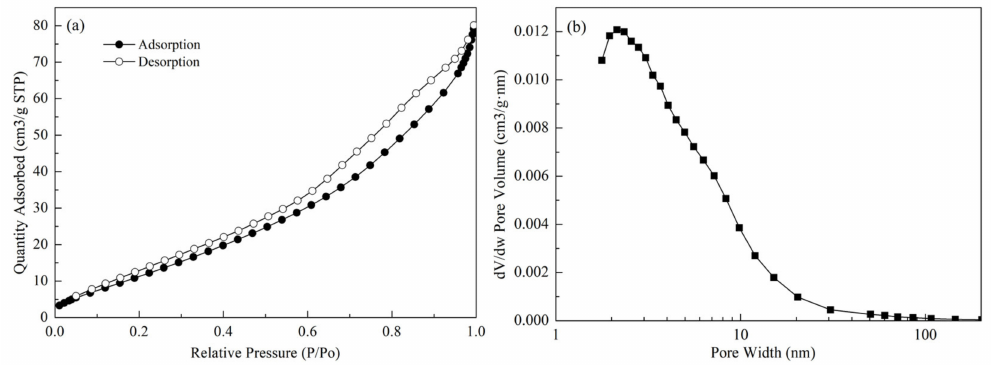
Figure 3. Adsorption desorption curve ( a ) and pore size distribution ( b ) of roasted